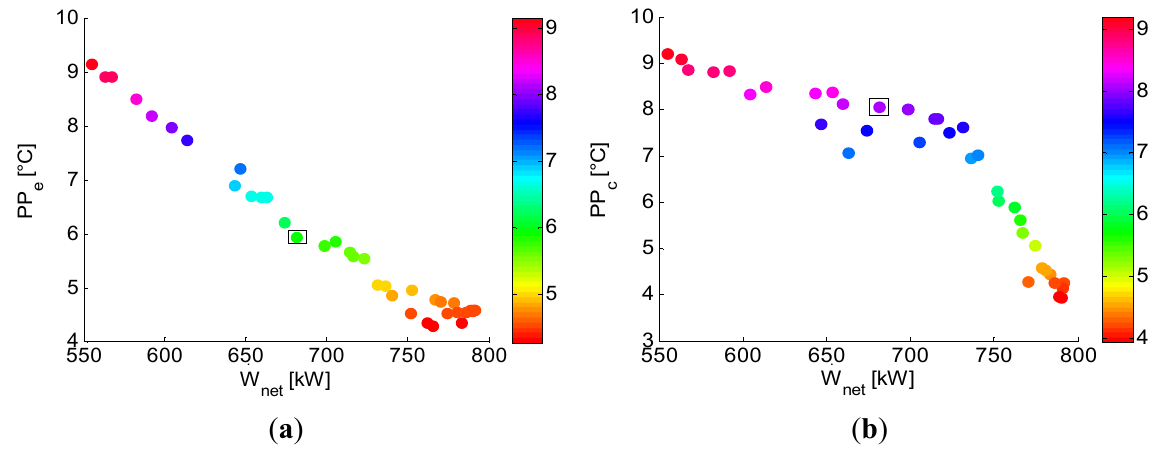
and ( b ) (cid:1842)(cid:1842) in function of net power output ( (cid:1849)(cid:4662) (cid:3032) (cid:3030)